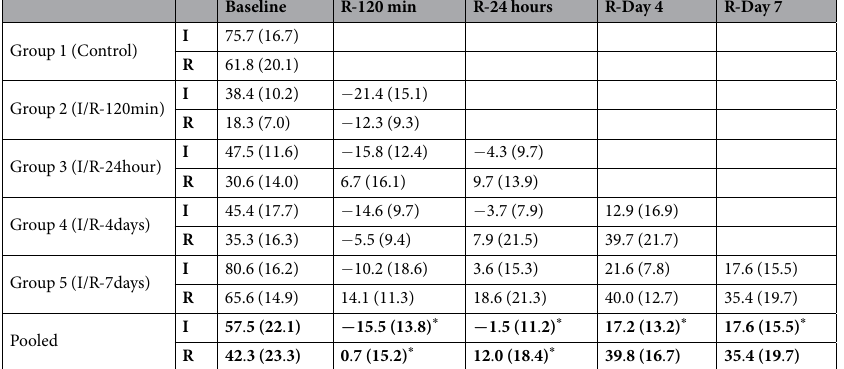
Table 1. Left ventricular regional systolic wall thickening analysis in the ischemic and remote pig myocardium during the first week after I/R. Left ventricular regional systolic wall thickening in the ischemic and remote myocardium, reported as mean % (standard deviation). A priori pairwise comparisons between baseline and pooled data for each time point were performed using generalized linear mixed models. Multiple comparison adjustment of p-value was performed according to the sequential Holm-Bonferroni procedure. * Statistically significant differences (p < 0.05) between baseline and corresponding pooled time-point data. The different myocardial states (ischemic vs. remote) were initially defined by the localization relative to late gadolinium enhanced defined infarction 41,42 . In the case of baseline imaging, i.e. before ischemia/reperfusion, such a definition was retrospectively performed based on follow-up imaging; while matched areas were selected in the case of controls. I: Ischemic; R: Remote